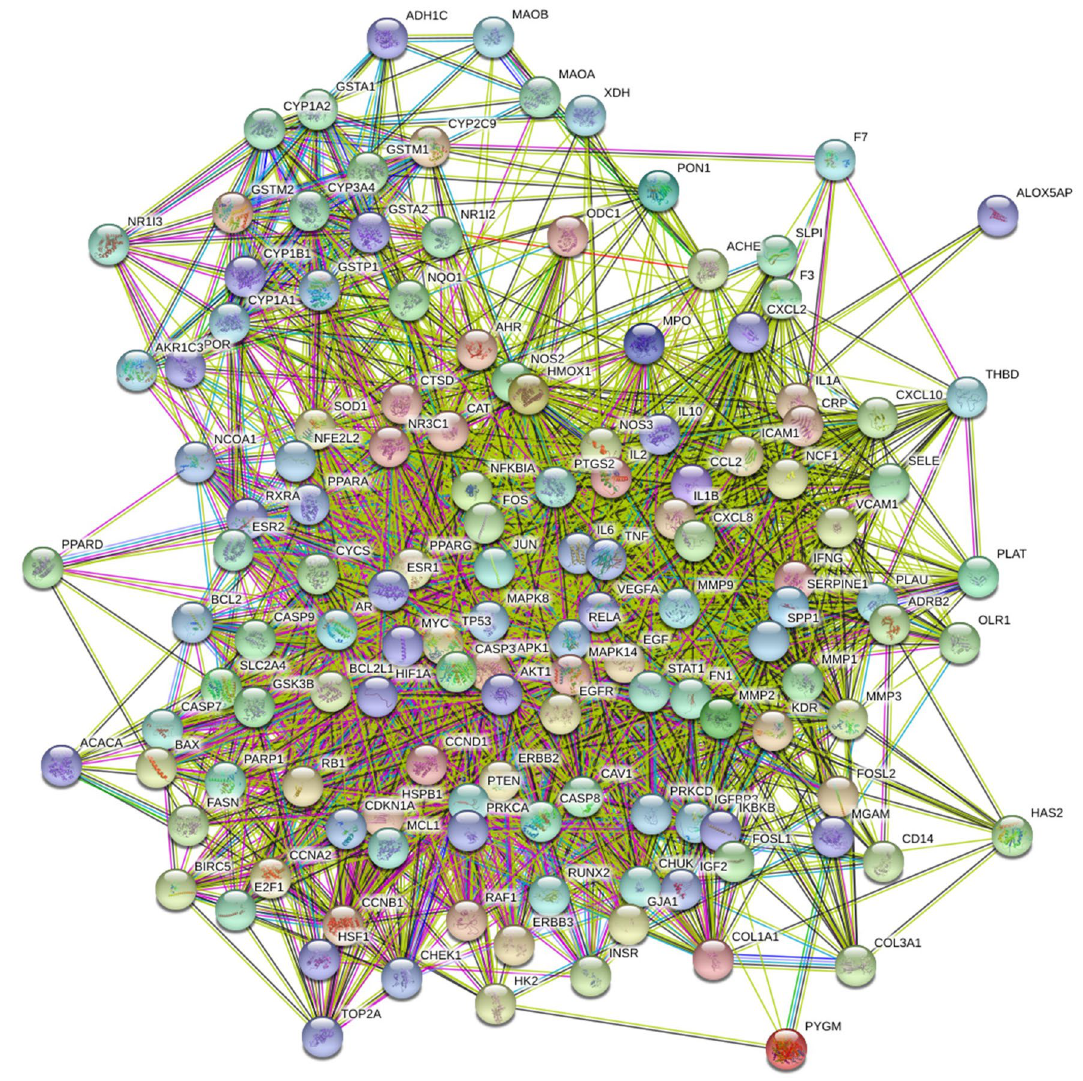
Figure 5 . PPI network compound targets against HLP. The original PPI data generated from the STRING database showing the detailed interactions of the targets.